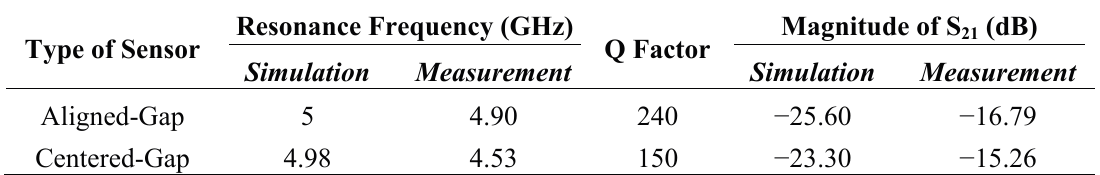
magnitude in 21